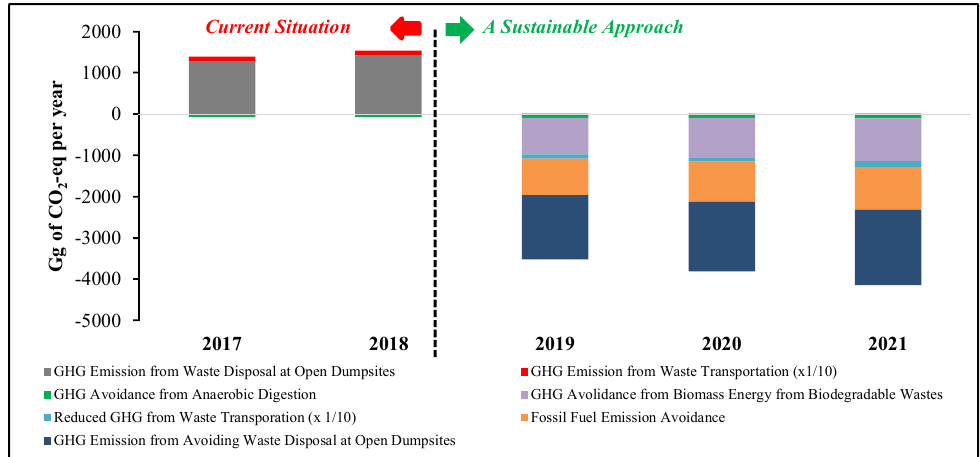
Figure 9. Total estimated greenhouse gas (GHG) emissions from biodegradable waste disposal in the current situation of Myanmar.